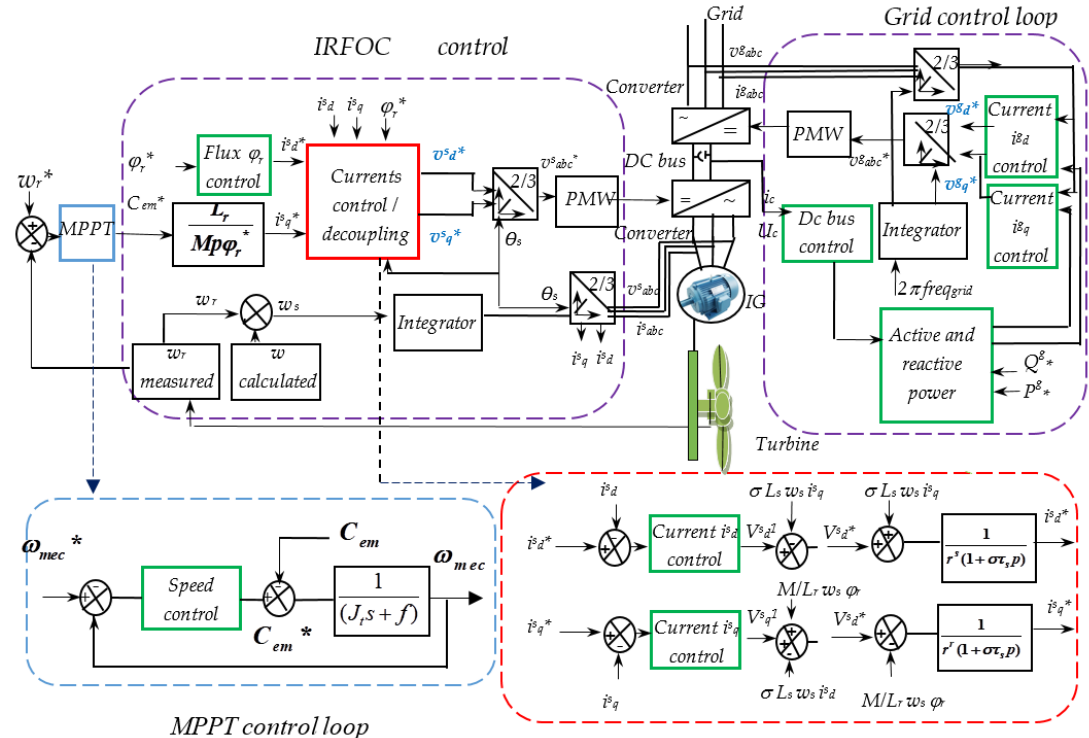
Figure 2. Schematic representation of the grid-connected wind turbine-driven IG with the three cotrol loops (MPPT, IRFOC and grid control loops).